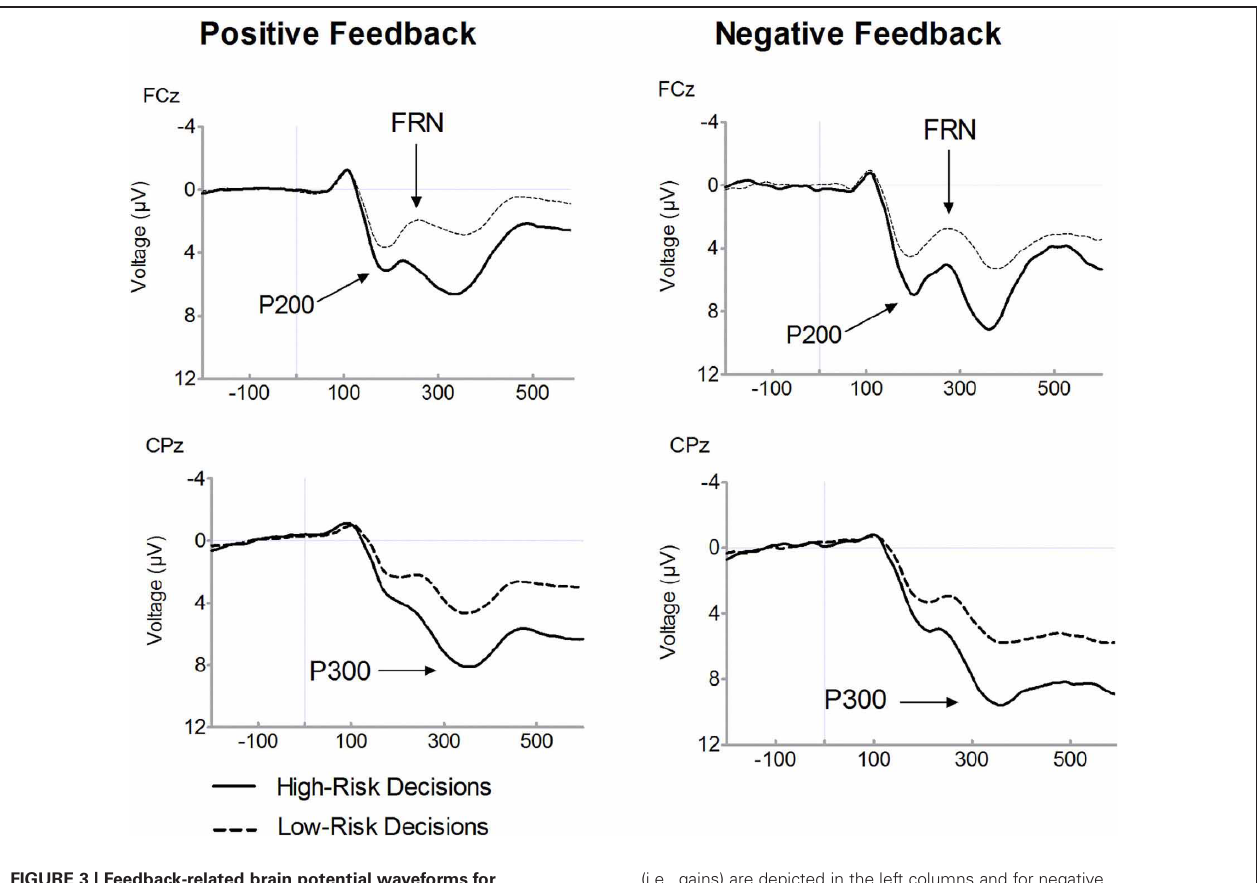
FIGURE 3 | Feedback-related brain potential waveforms for positive (i.e., gains) and negative feedback (i.e., losses). Averaged feedback-locked event-related brain potential (ERP) waveforms are presented for recording sites FCz and CPz. ERPs for positive feedback